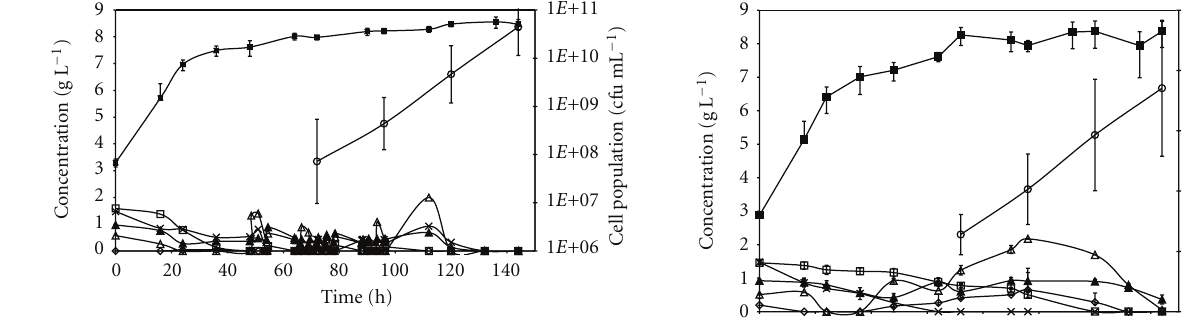
Figure 3: Acid utilization and growth of Ralstonia eutropha with 3 h interval additions of ARF. The values for cell count ( (cid:2) ), acetic acid utilization ( (cid:3) ), butyric acid utilization ( ♦ ), lactic acid utilization ( (cid:5) ), propionic acid utilization ( (cid:6) ), succinic acid utilization ( × ), and PHA concentration (O) are indicated. Values are the means of two replications with standard deviation showed by error bars.